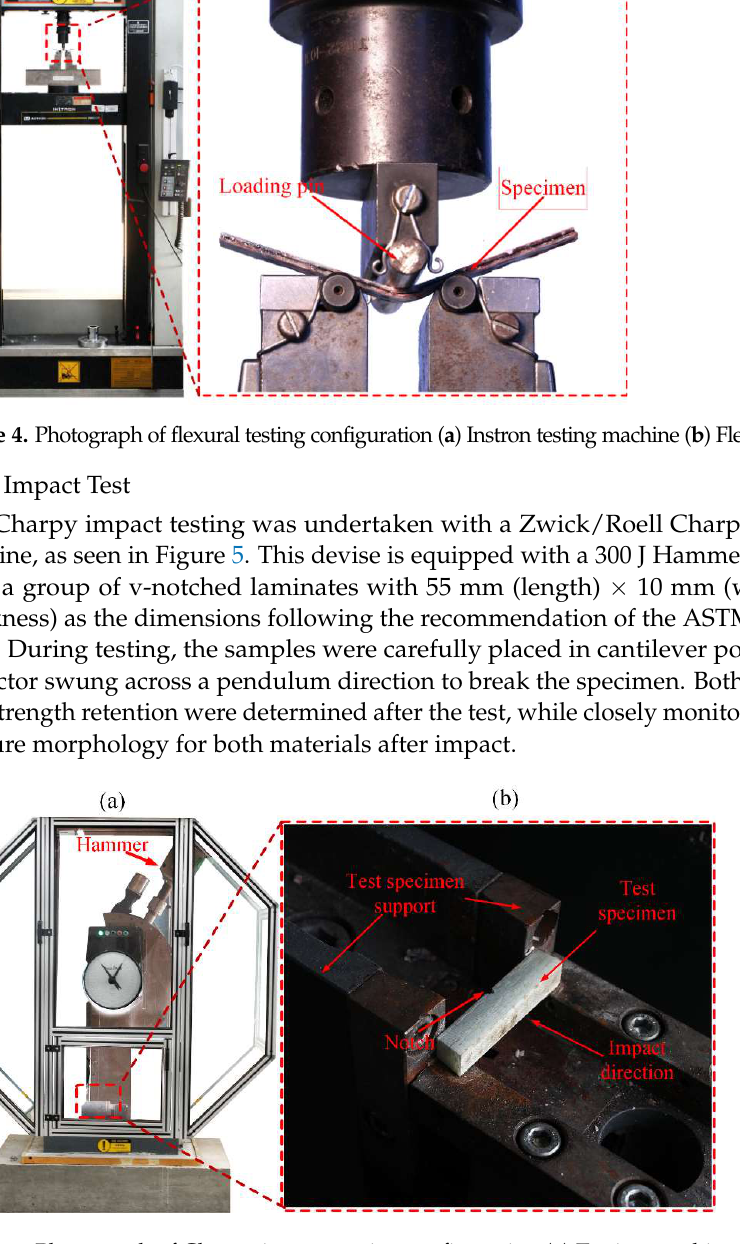
Figure 5. Photograph of Charpy impact testing configuration ( a ) Testing machine ( b ) Charpy impact test specimen.